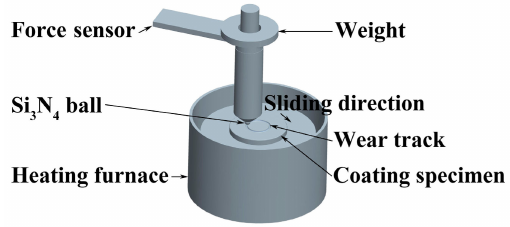
Figure 1. Schematic diagram of wear test.